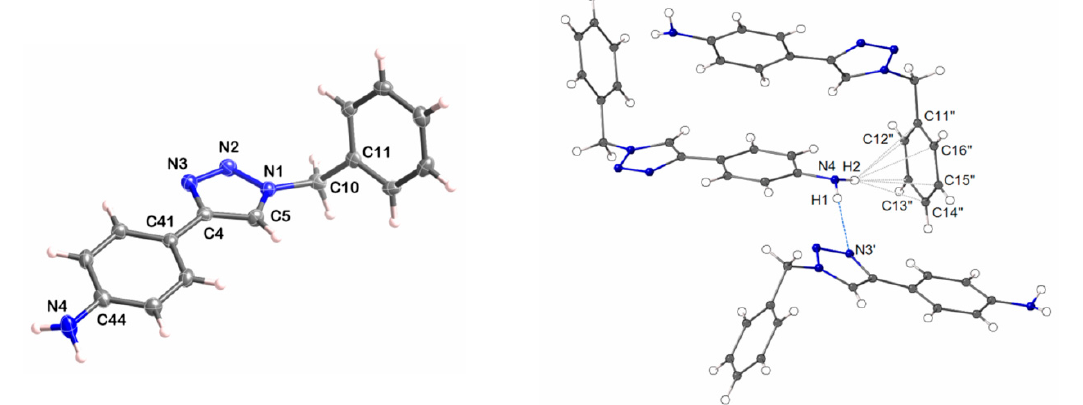
Figure 3. ( Left ) Ellipsoid plot (50% probability level) for 3h with the atom numbering scheme. ( Right ) Packing view showing the interactions involving the NH 2 group. Selected bond lengths and angles (Å°): N(1)–N(2), 1.3409(19); N(1)–C(5), 1.342(2); N(1)–C(10), 1.468(2); N(2)–N(3), 1.3211(19);